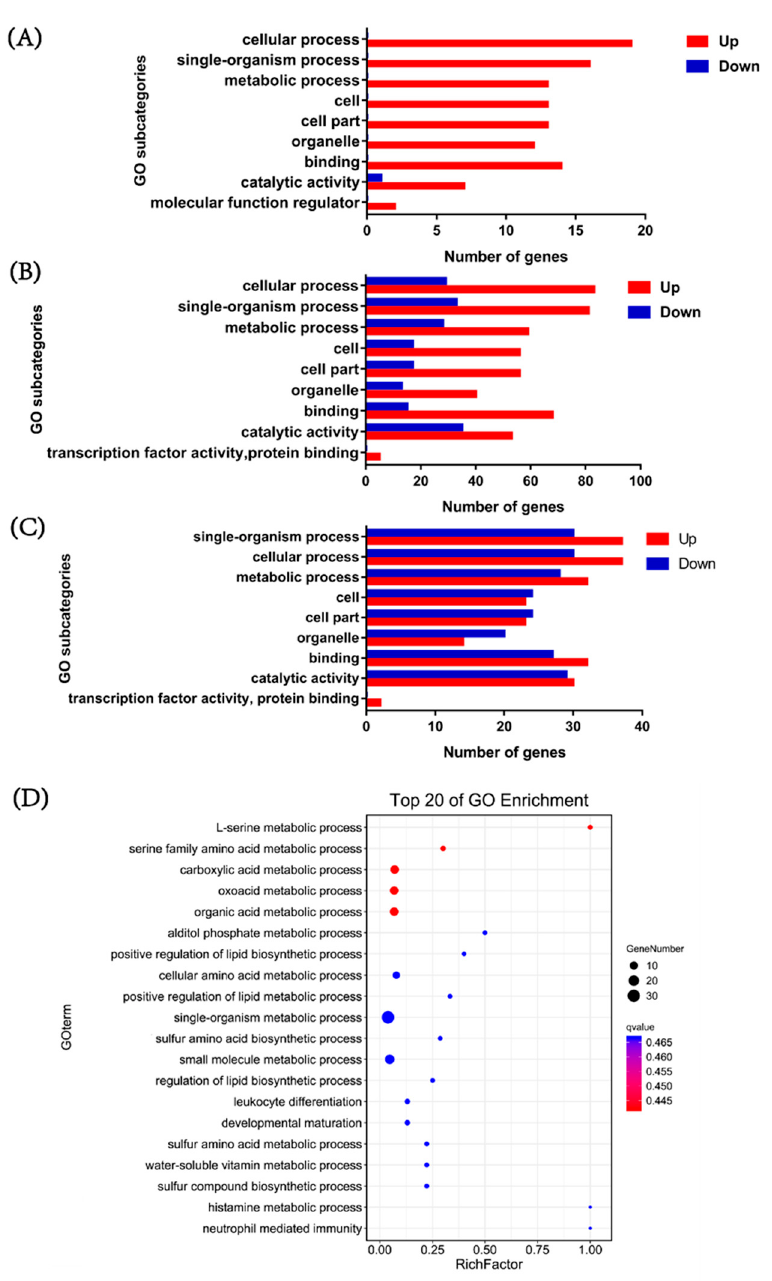
Figure 2. Gene ontology (GO) functional enrichment analysis of DEGs in pairwise comparisons between three time points. The column showed quantity of up(red)- and down(blue)-regulated DEGs. ( A ) Enriched GO items from the 6 hpi vs. 0 hpi comparison. ( B ) Enriched GO items from the 12 hpi vs. 0 hpi comparison. ( C ) Enriched GO items from the 12 hpi vs. 6 hpi comparison. ( D ) The most enriched biological processes from the 12 hpi vs. 6 hpi comparison.